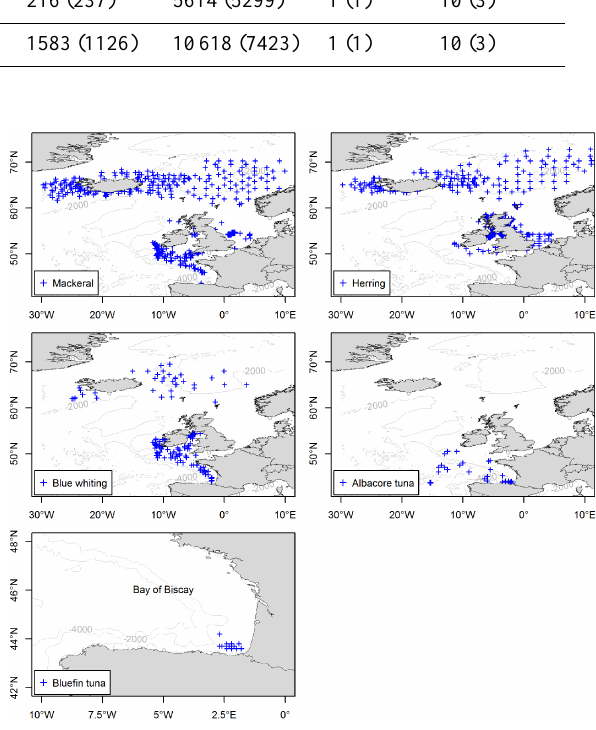
Figure 2. Location of stomach content samples (circles) for the five pelagic species collected in the northeast Atlantic and submitted to the DAPSTOM and AZTI